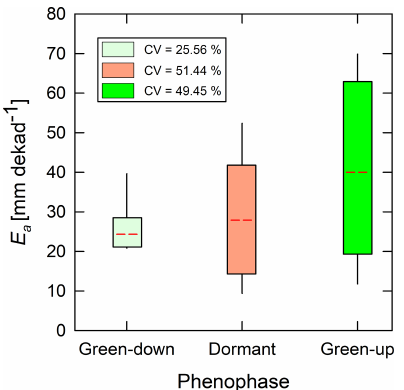
Figure 12. Box plots showing variations in satellite-based evapora- tion estimates at dekadal scale across phenophases. Dotted red line is the mean for each phenophase. Coefficients of variation (CV) of satellite-based evaporation estimates were largest during the dor- mant and green-up